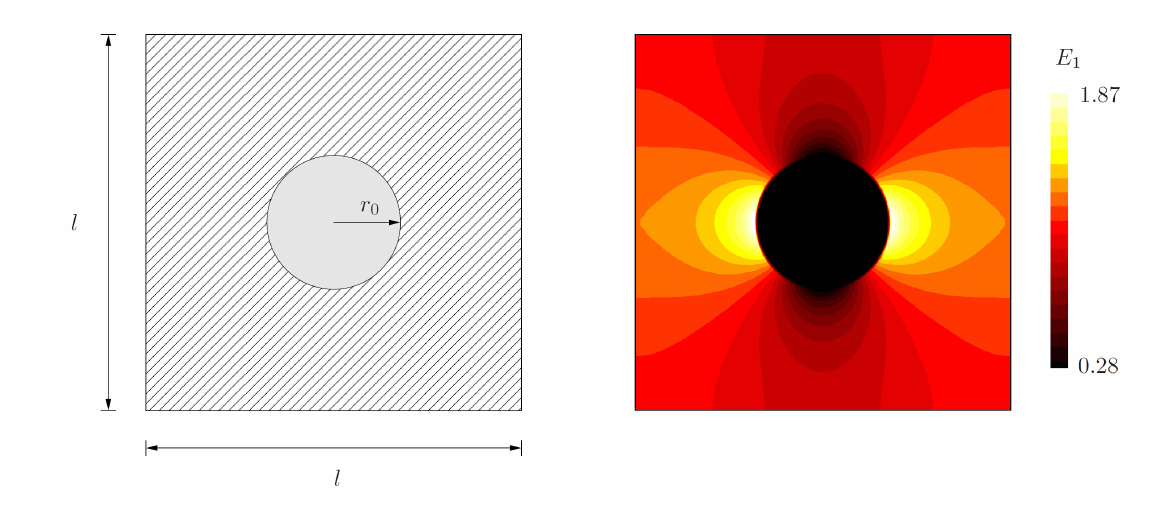
Figure 6. Microstructure of length l with a circular inclusion having the radius r 0 = 0.178 l . On the right, a finite element solution for a phase contrast of 10 and a loading of E 1 = 1 and E 2 = 0 is